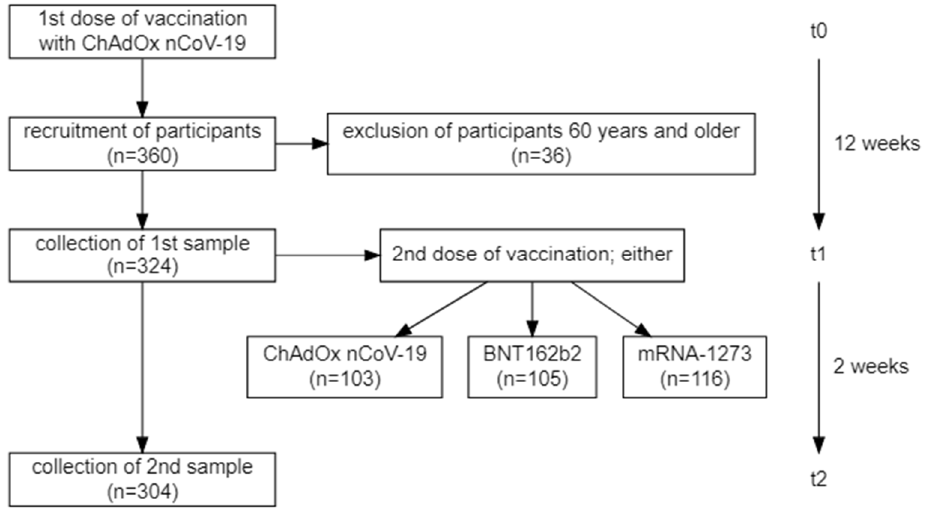
Figure 1. Flow diagram showing the vaccination program and the recruitment of participants for the current study and the respective time intervals in between the different time points.